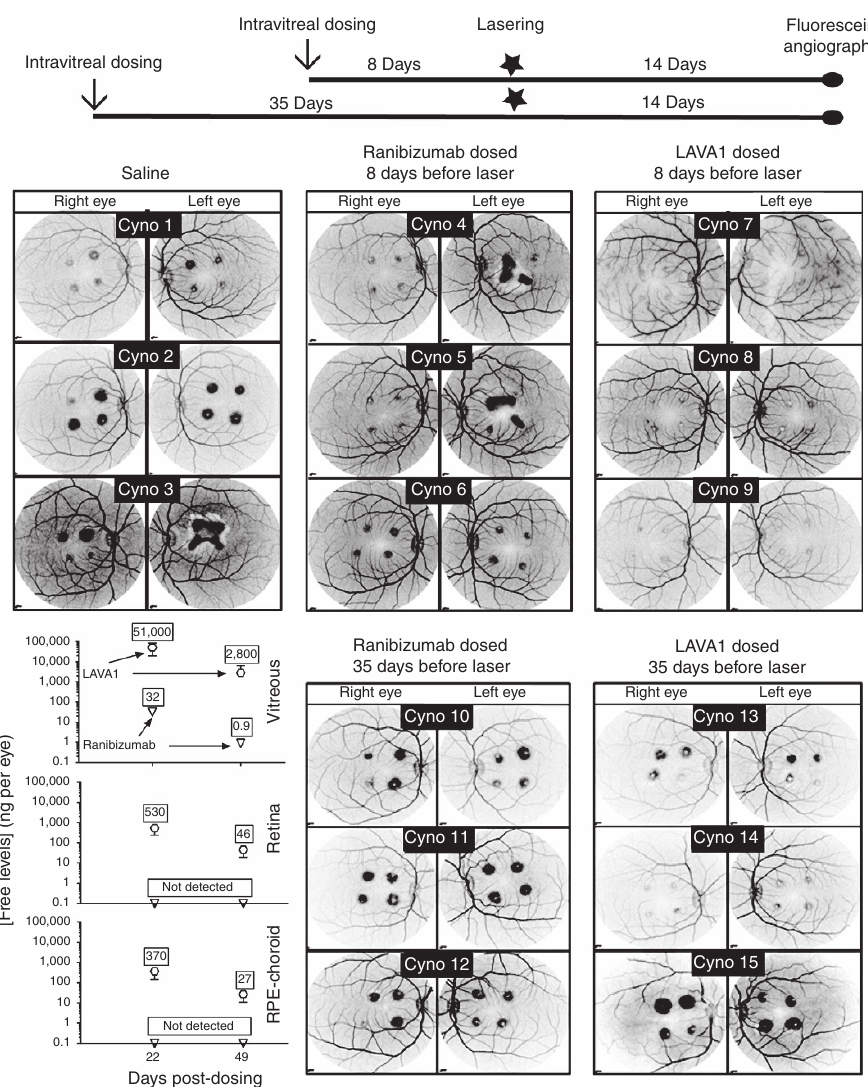
Figure 4 | Efficacy of ranibizumab and LAVA1 in the cynomolgus monkey laser-CNV model. Laser photocoagulation to induce CNV lesions was applied 1–5 weeks after drugs were dosed. Late-phase fundus images from cynomolgus monkey eyes injected with ranibizumab or LAVA1 taken approximately 5min post-intravenous fluorescein injection. The fundus images are shown as negatives (black and white reversed) to highlight the CNV-induced vascular leakage of fluorescein during fluorescein angiography. Cynomolgus monkeys 1–9 were imaged 22 days after dosing, whereas cynomolgus monkeys 10–15 were imaged 49 days after dosing. Each eye received four laser burns producing neovascular tufts (CNV) that appear as dark spots in the images; the darkness corresponds to the degree of vascular leakage from the CNV lesions. When dosed 8 days before laser, a single dose of ranibizumab only partially inhibited laser-induced CNV, whereas a single dose of LAVA1 completely inhibited laser-induced CNV. The plot (bottom left) shows average terminal levels of free (unbound to VEGF) LAVA1 and free ranibizumab in the cynomolgus monkey eyes 22 and 49 days post-intravitreal injection. Drug concentrations less than the lower limit of quantification (0.1ng per eye) were categorized as ‘not detected’. At both day 22 and 49, free LAVA1 levels in the vitreous, retina and RPE-choroid were markedly higher than free ranibizumab. Error bars represent 1 s.d. Measurements were done in